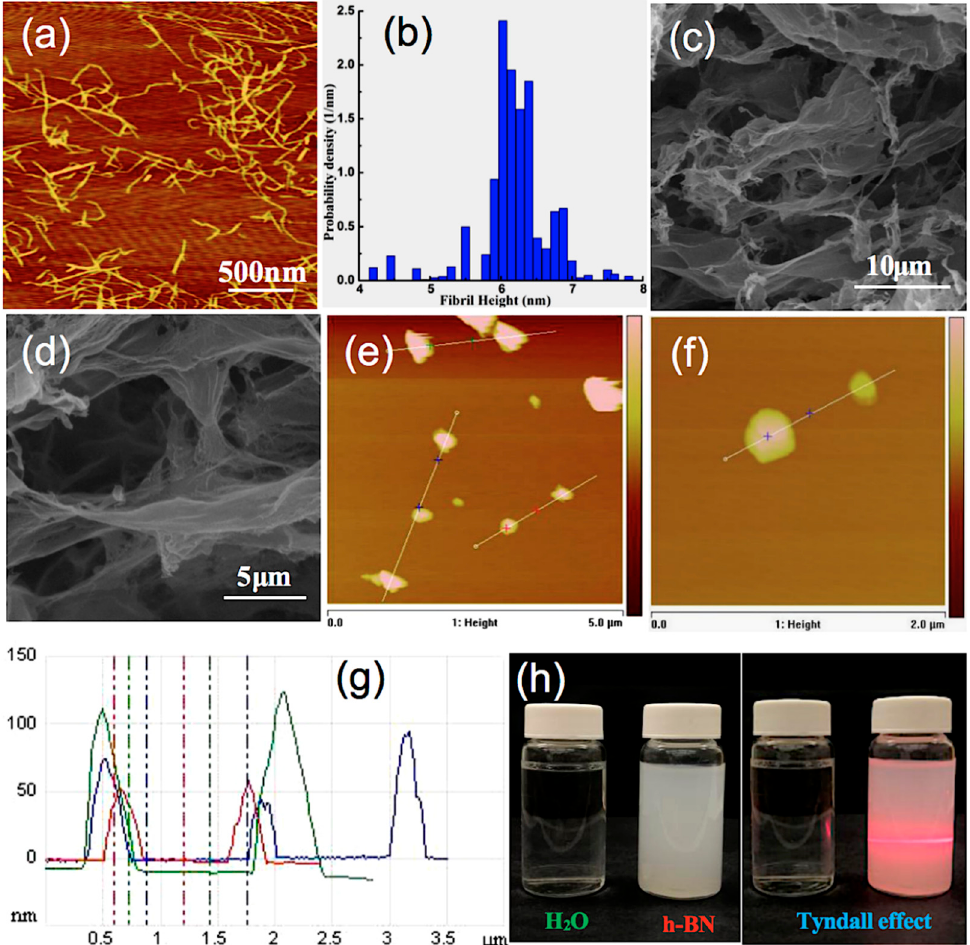
Figure 2. ( a ) Atomic force microscope (AFM) image of CNF. ( b ) The corresponding height distribution measured from AFM topographic data of CNF. ( c , d ) Scanning electron microscope (SEM) images of CNF aerogel under different magnifications. ( e ) and ( f ) AFM images of h-BN under different magnifications. ( g ) The corresponding height distribution measured from AFM topographic data from Figure e. ( h ) Tyndall phenomenon of h-BN suspension.